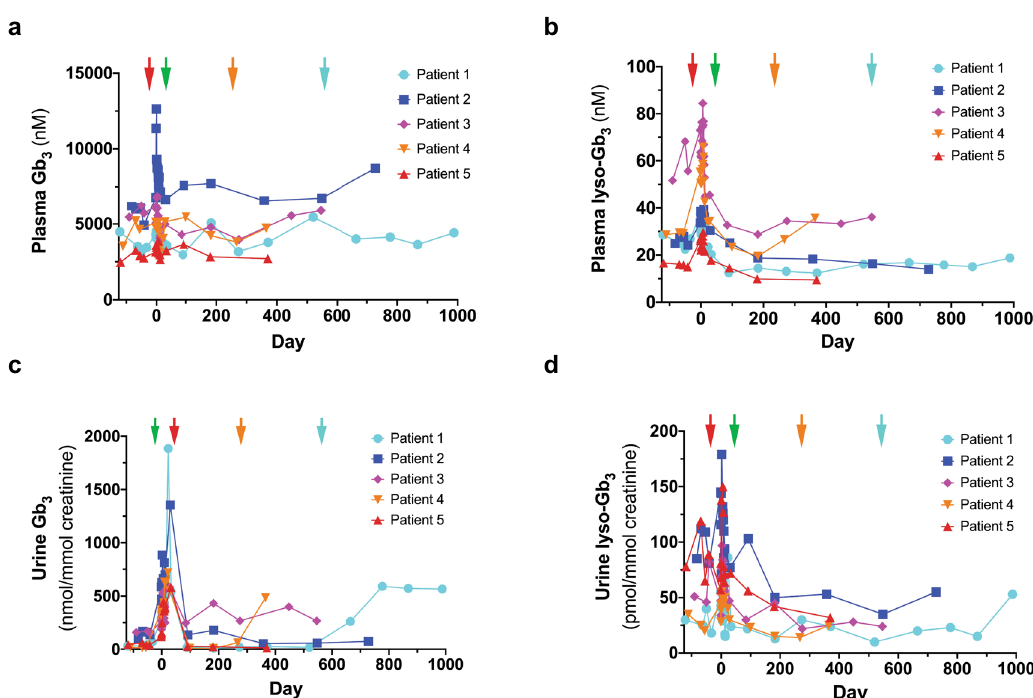
Fig. 3 Total plasma and urine globotriaosylceramide (Gb3) and lyso-Gb3 levels. Plasma Gb3 ( a ), plasma lyso-Gb3 ( b ), urine Gb3 ( c ), and urine lyso-Gb3 ( d ) levels are illustrated for each patient. Red arrow is at Day − 30 when ET was stopped prior to mobilization. Green arrow is at Day 30 when ET was restarted for Patients 1, 2, 4, and 5. The orange arrow demarks when Patient 4 stopped ET at Day 214 and the blue arrow is when Patient 1 stopped ET at Day 548. Patient 3 chose not to restart